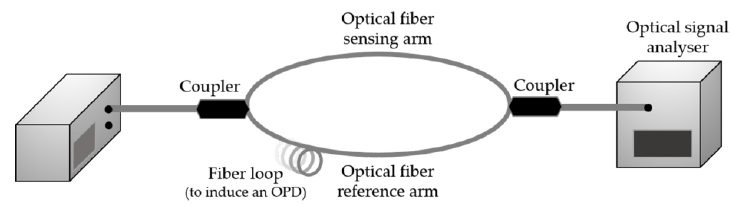
Figure 15. Experimental diagram of an MZI based on two optical fibers with different lengths.